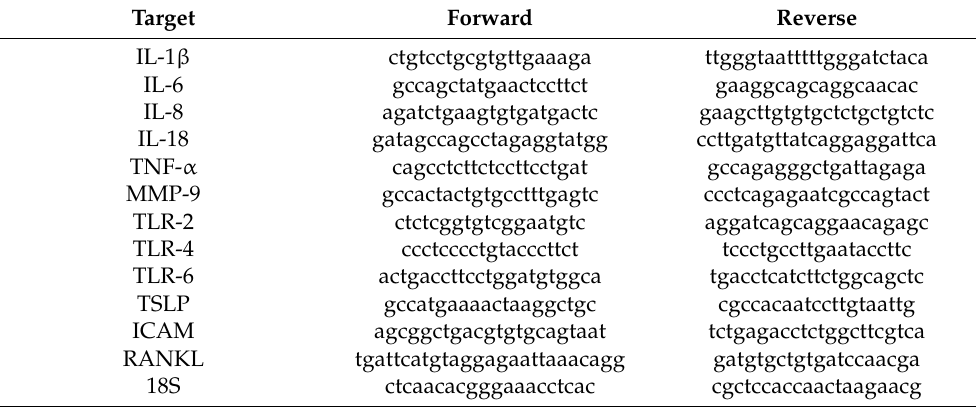
Table 1. Sequences of primers